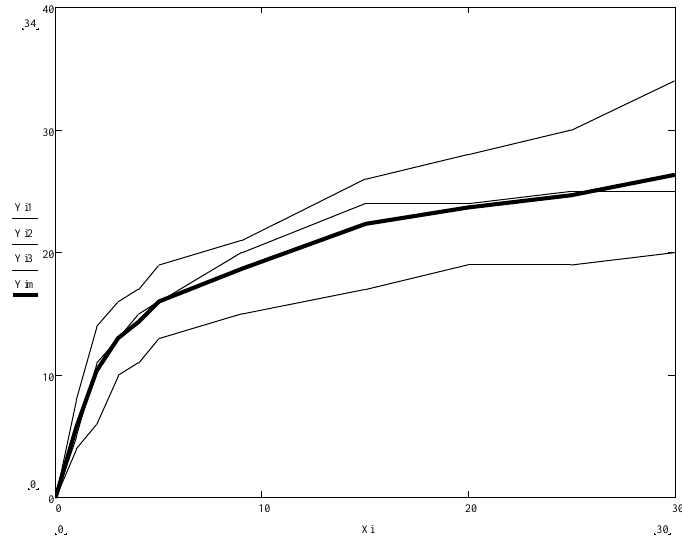
Fig. 3. Graph of changes in linear wear for a pair of samples made of unmodified steel 45; counterbody - implanted by the electrospark